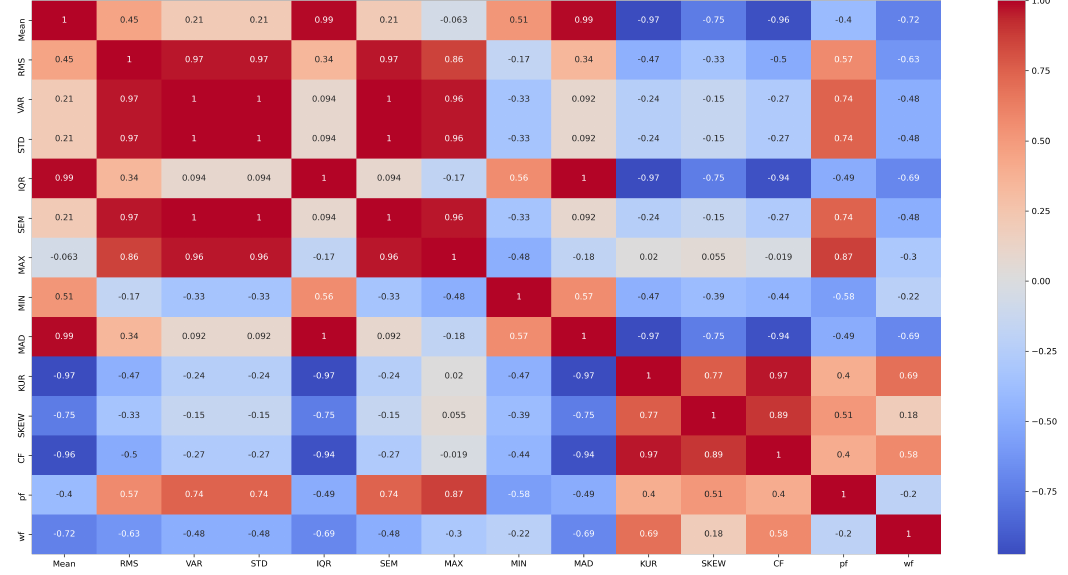
Figure 16. Feature extraction plot for all parameters in the dataset.